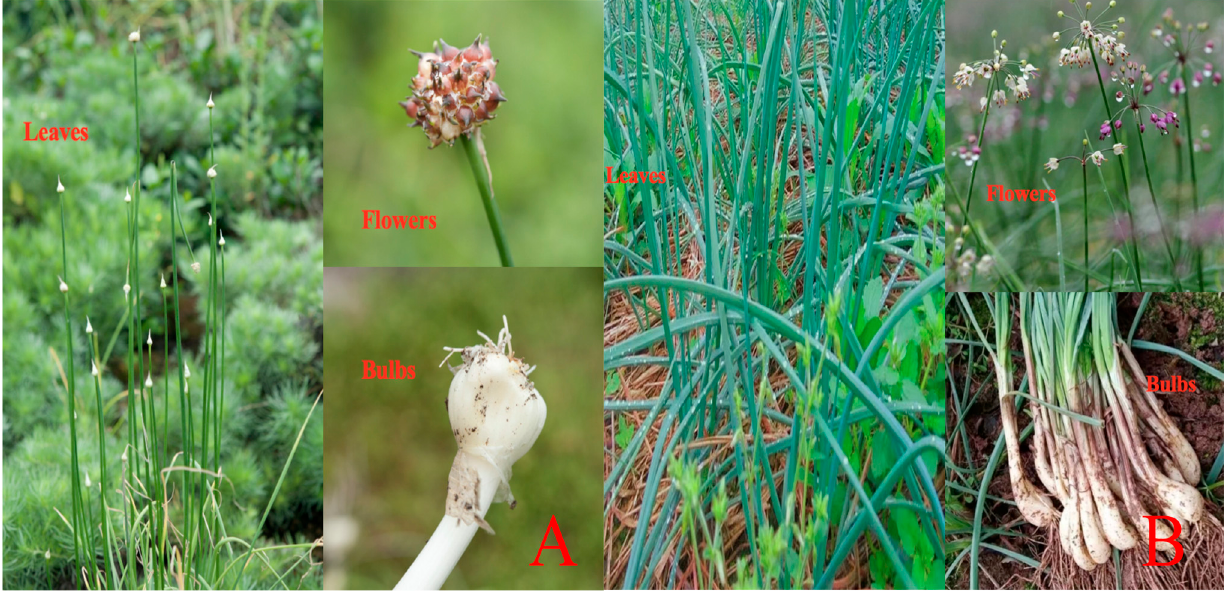
Figure 1. Plants form of A. macrostemon ( A ) and A. chinense ( B ) (www.gbif.org, accessed on 18 April 2022.).